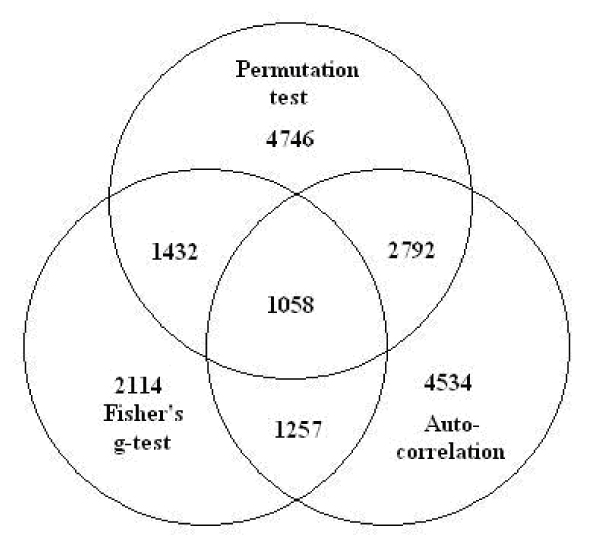
The number of oscillating genes revealed by three different algorithms. 5400 genes are reported by at least one algorithm. The most number of oscillating genes is revealed by Pt-test.